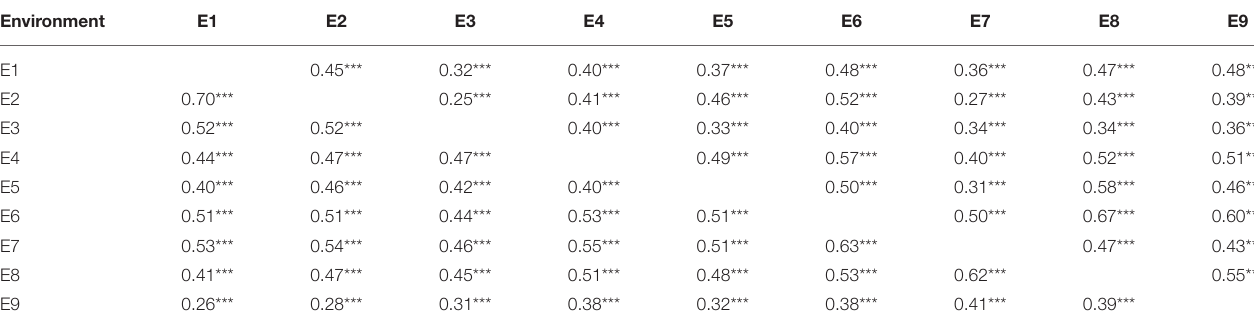
TABLE 3 | Pearson correlation coefficients of GZn and GFe in the Jingdong 8/Bainong AK58 RIL population among nine environments. Environment